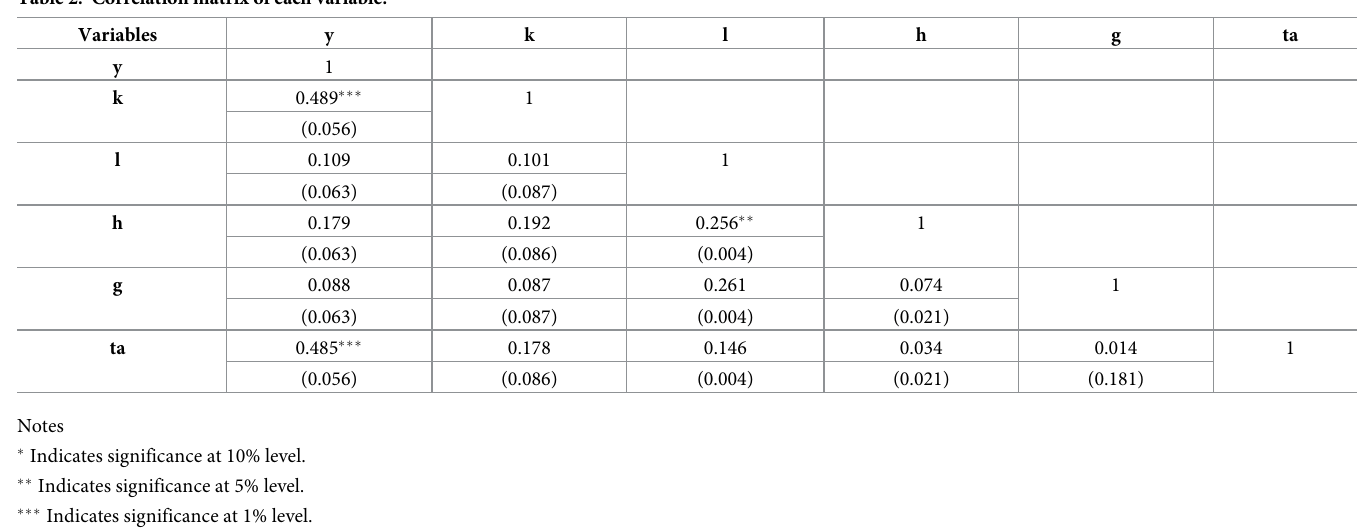
Table 2. Correlation matrix of each